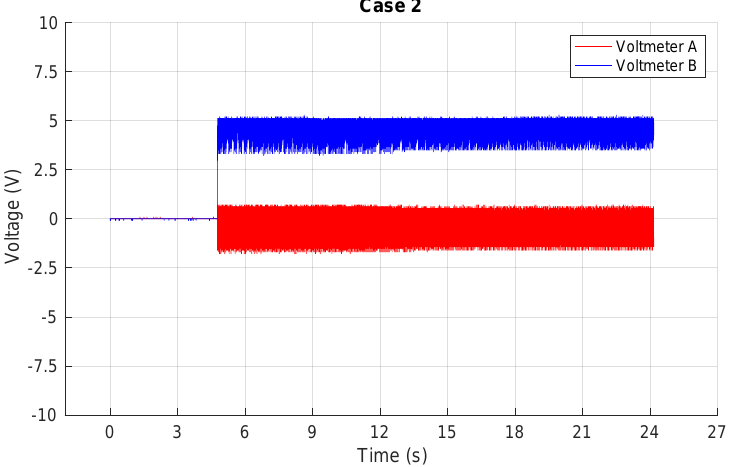
Figure 10. Case 2: Experimental results, where a change in soil resistivity is hard to read.